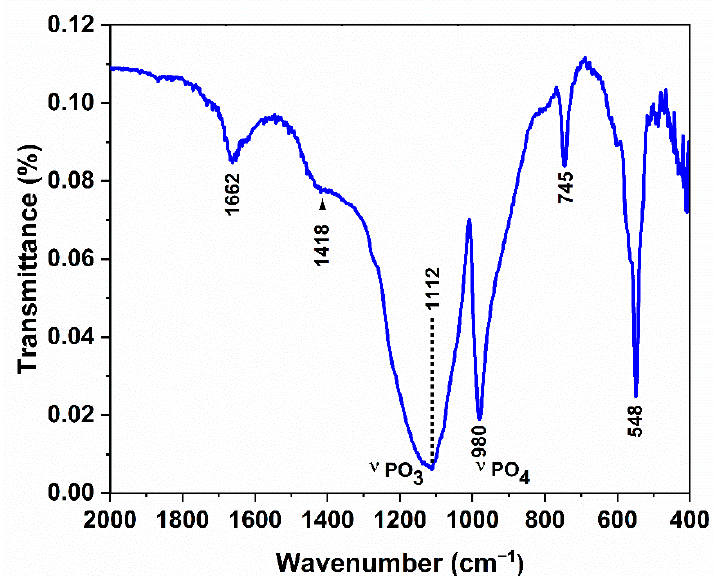
Figure 3. FTIR spectrum of ZrP 2 O 7 .